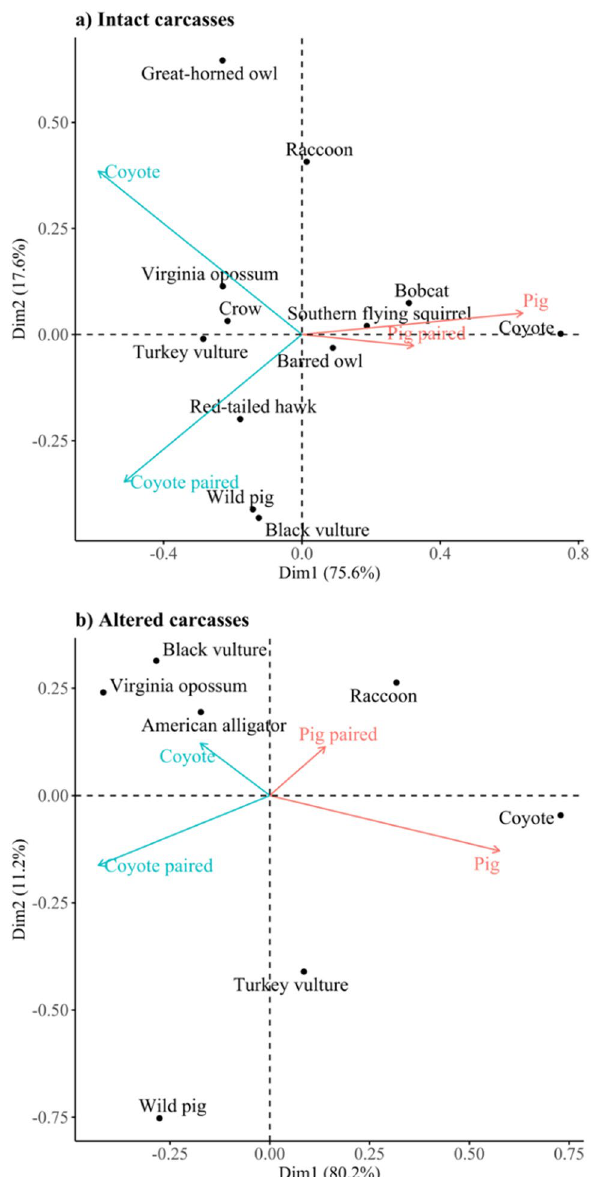
Figure 2. Contribution biplot depicting the result of the correspondence analysis for ( a ) intact carcasses and ( b ) altered carcasses investigating vertebrate scavenger species (black dots) occurrence on the four carcass configurations (red arrows) with variance shown in paratheses based on scavenging trials completed in February–June 2021 at the Savannah River Site in Aiken, SC,